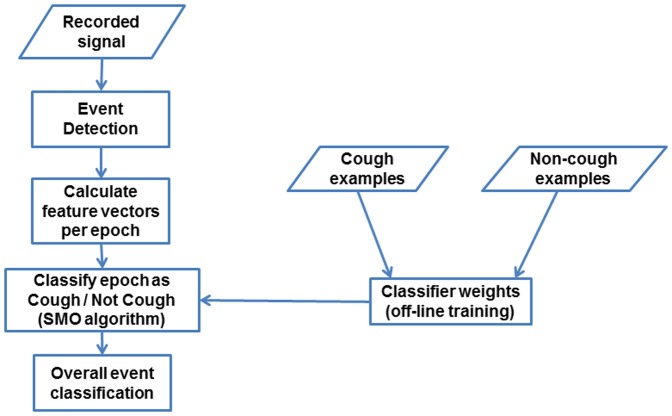
High-level flowchart of cough detection algorithm.